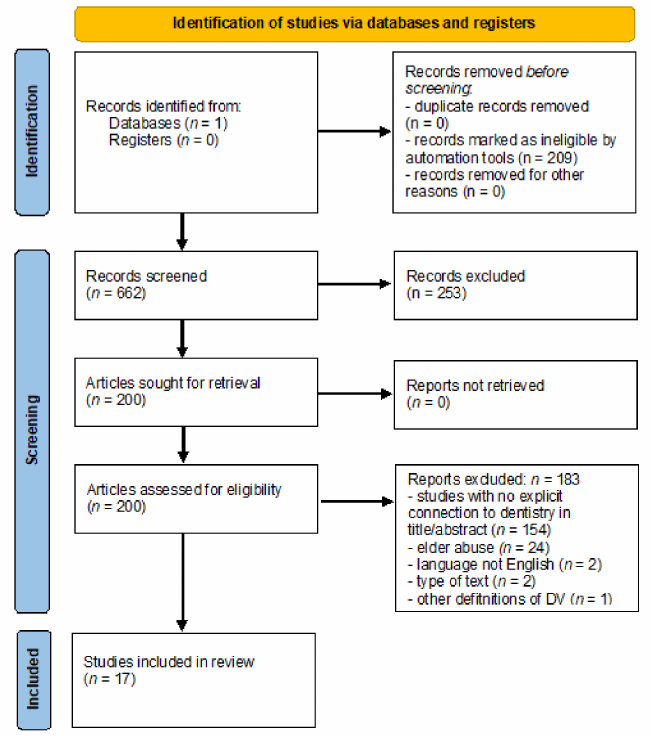
Figure 1. PRISMA 2020 flow diagram for new systematic reviews, which includes searches of databases and registers only [13]. Search process in PubMed based on our chosen keywords. Four steps were performed: identification, screening, eligibility assessment and the final inclusion of papers. Papers were included from the time period of January 2020 to October 2021, starting with 662 papers and finally including 17 according to our defined eligibility